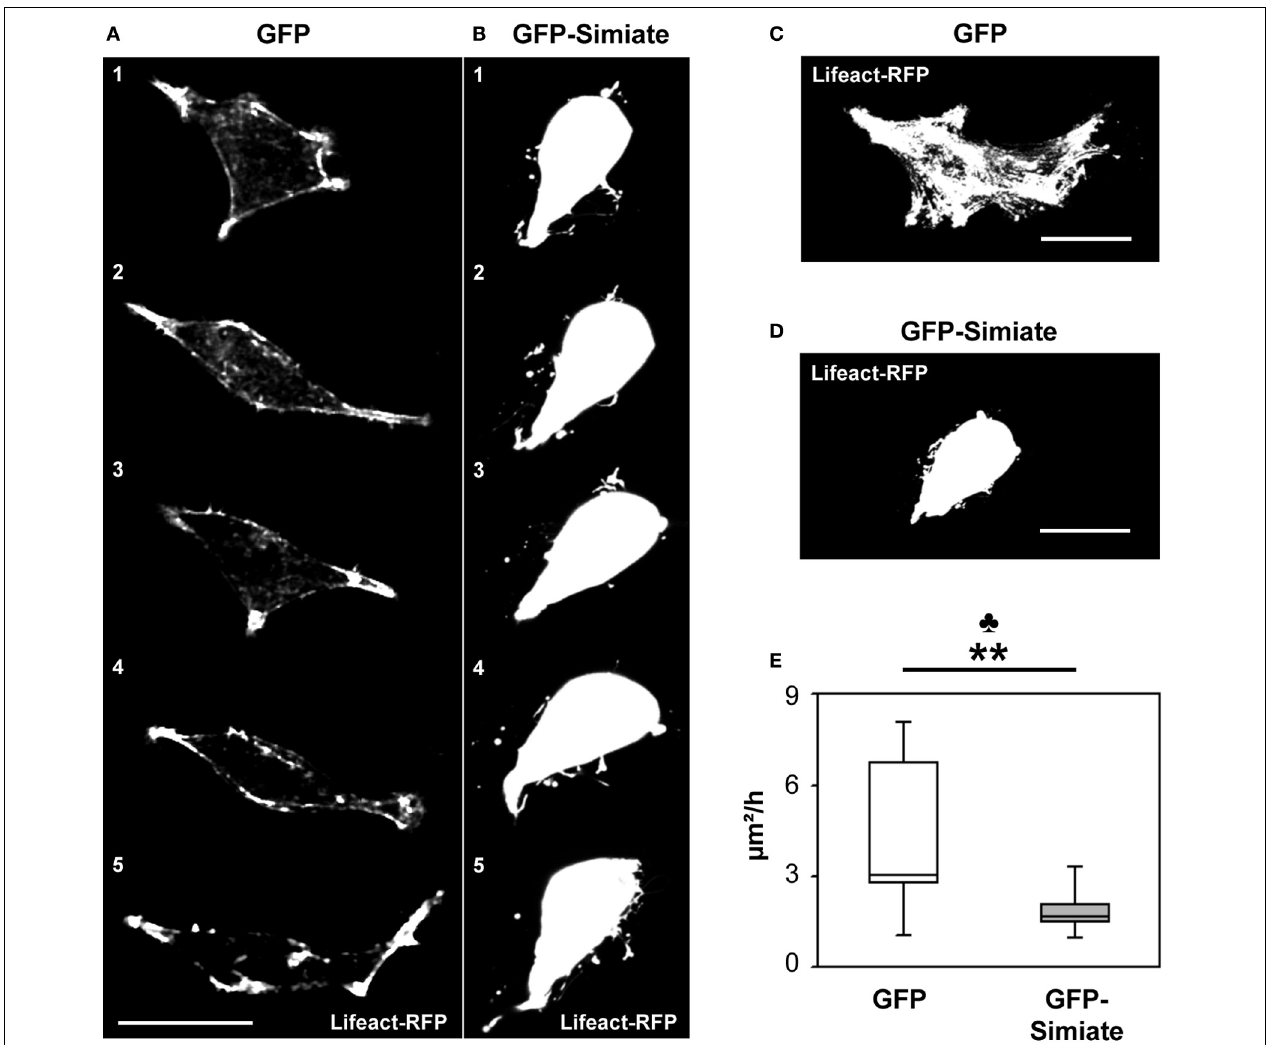
FIGURE 3 | Simiate influences the velocity of environmental exploration of cells. (A,B) Time series images of the most active GFP (A) and GFP-Simiate (B) expressing HEK-293 cell (z-projections). Meantime between pictures (1–5): 24min. (C,D) Time projections of a 2.2h recording period from the same cells. Scale bar: 20 μ m. Please note that the overlay of several images during